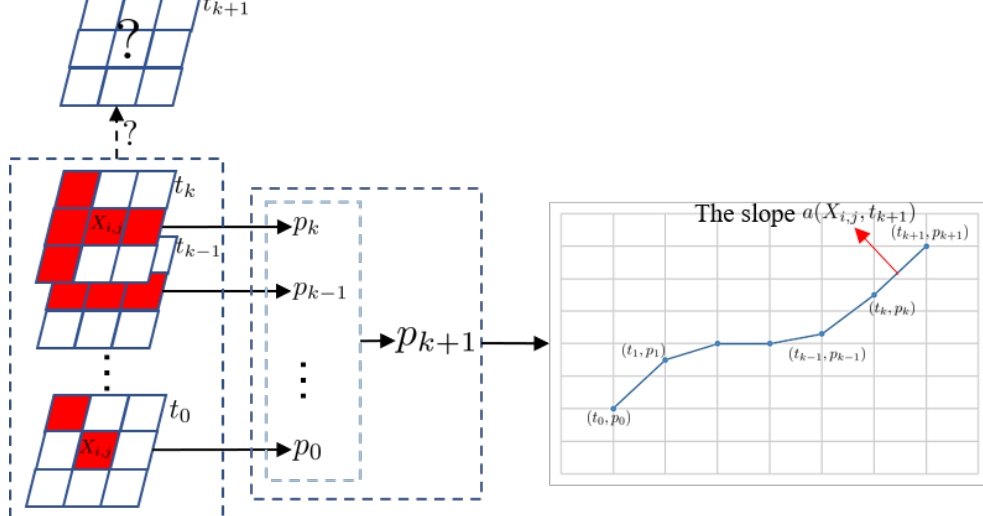
Figure 4. The process of solving the diffusion coefficient. The horizontal axis on the plot represents time, and the vertical axis represents probability